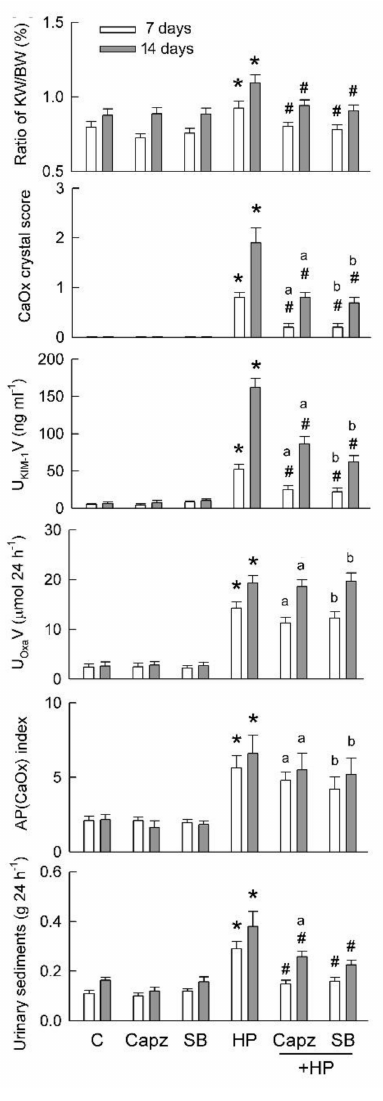
Figure 7. Chronic TRPV1 inhibition abolishes effect of hyperoxaluria on kidney injury and CaOx crystal formation. Basic data were obtained from metabolic cage study and collected over 24 h